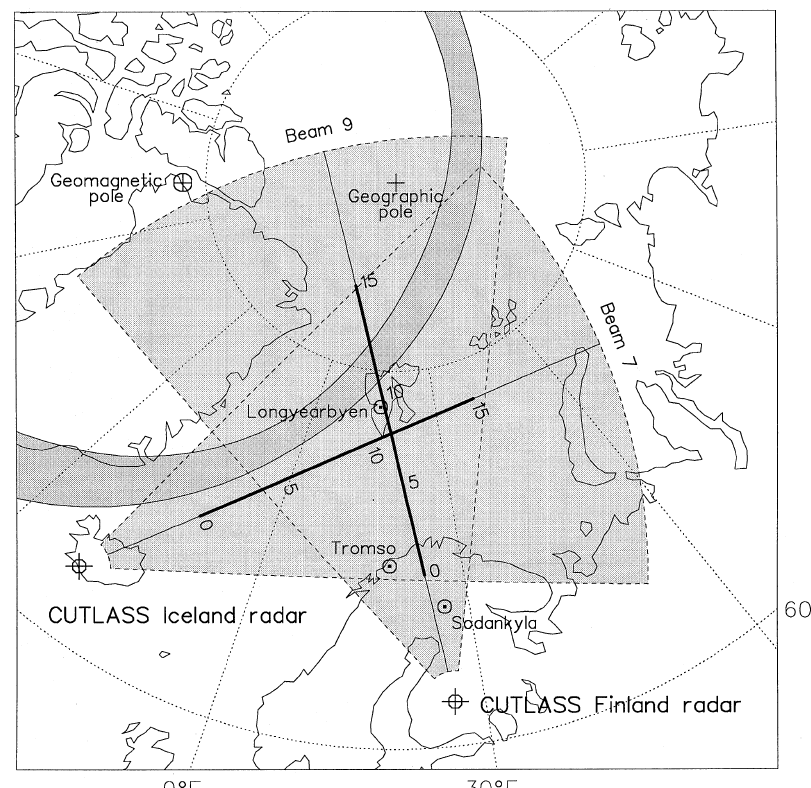
Fig. 2. The location of the summary points within the fields-of-view of the CUTLASS Finland and Iceland radars. Thin lines indicate the summary beams (9 and 7 for the Finland and Iceland radars respectively), the thick lines indicating the range interval over which summary data is collected. Numbers to the right of the thick lines indicate the numbering of the summary points. The locations of Tromsø , Norway, Sodankyla¨ , Finland, and Longyearbyen , Svalbard, are also indicated, along with the statistical location of the quiet ( K p (cid:136) 0) auroral oval at 06 UT (Feldstein and Starkov, 1967; Holz- worth and